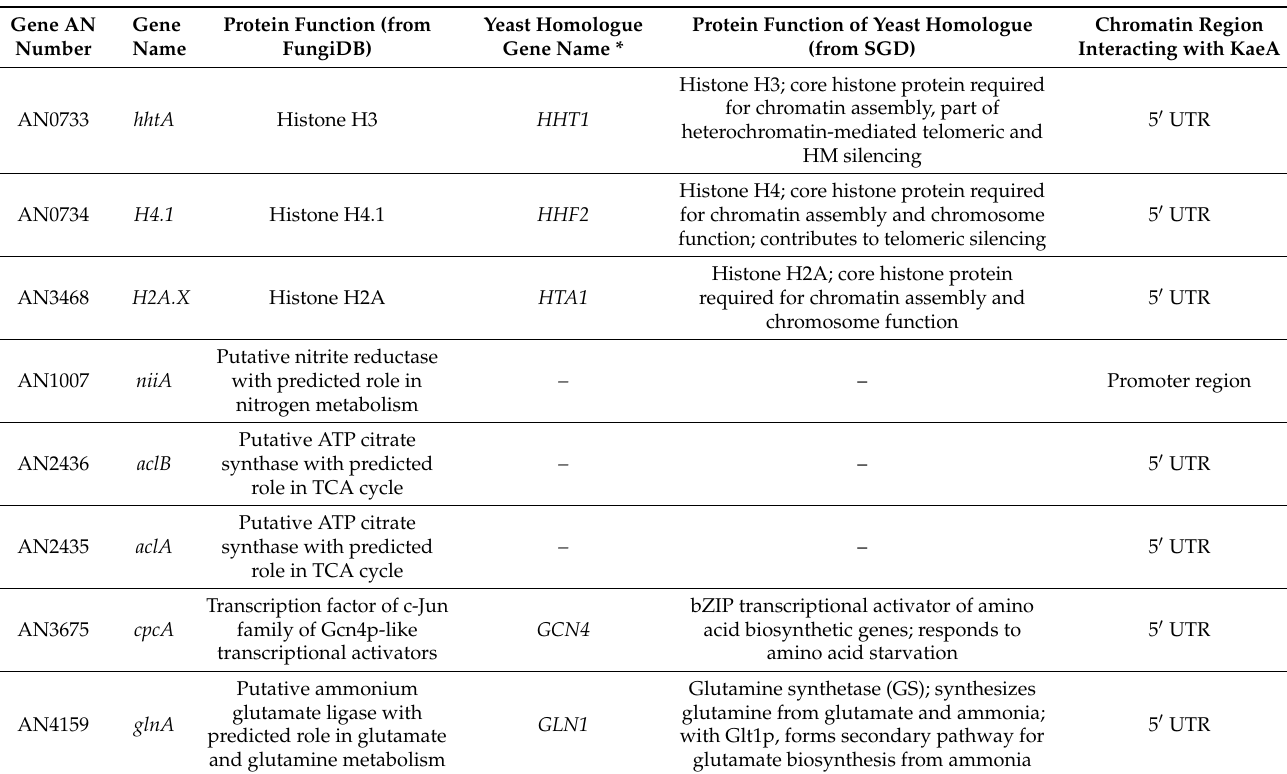
Table 3. Chromatin regions interacting with